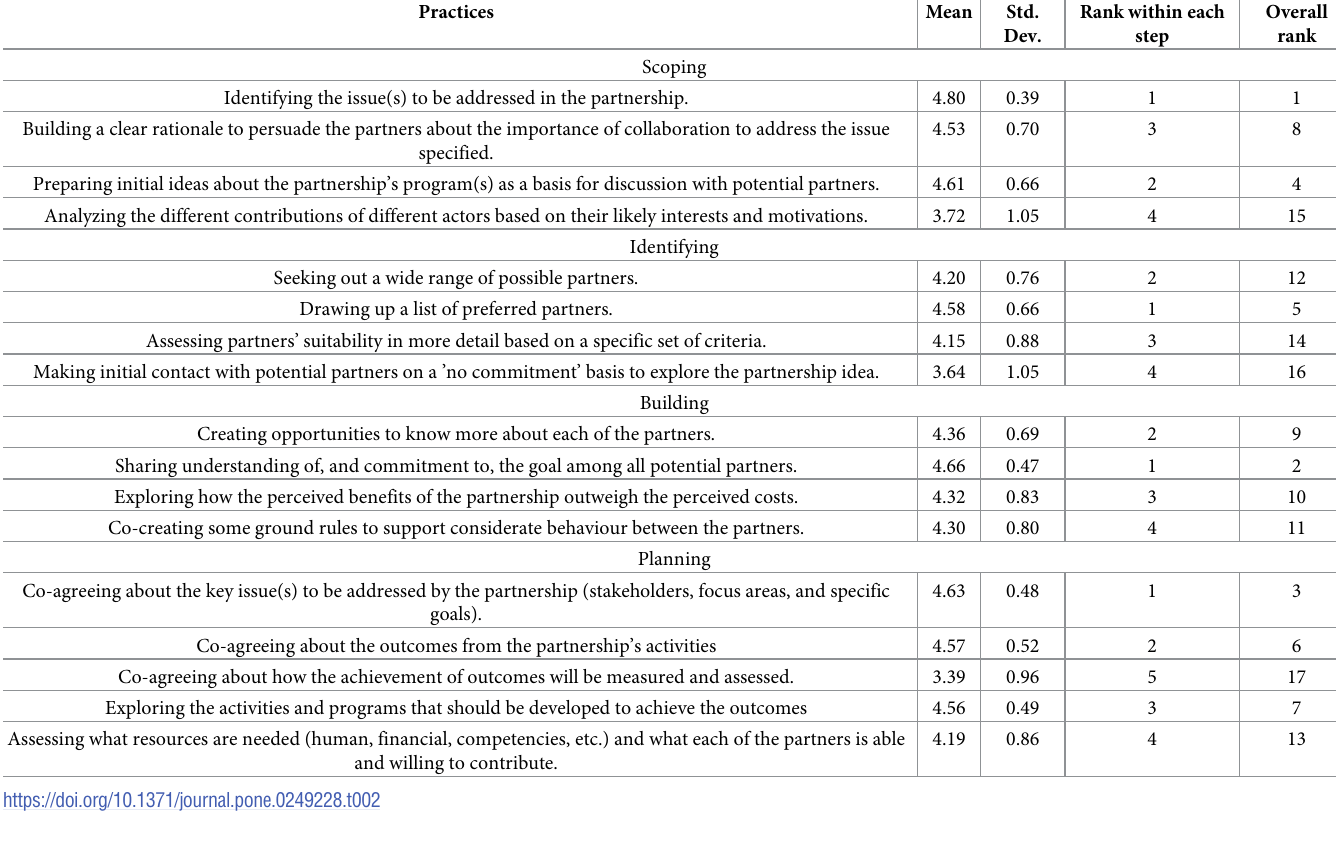
Table 2. Descriptive results of scoping and building practices followed by nonprofit organizations.